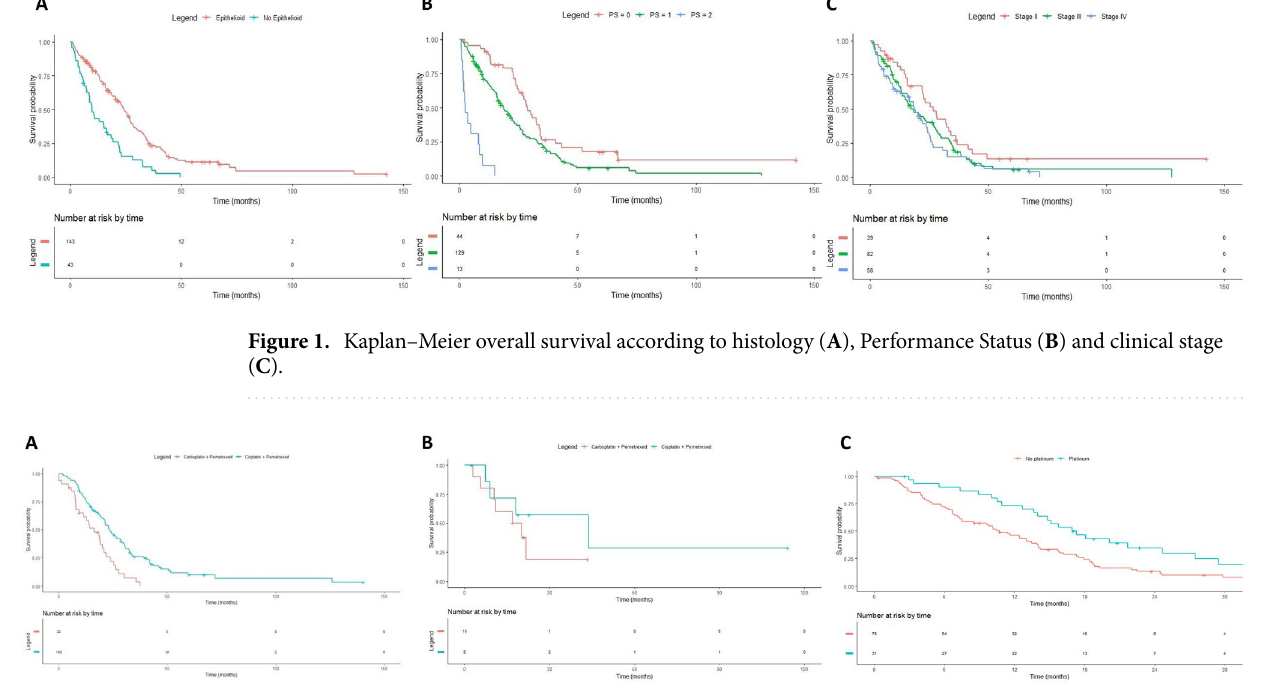
Figure 2. Kaplan–Meier overall survival according to type of systemic treatment: cisplatin versus carboplatin in first line ( A ), cisplatin versus carboplatin in second line ( B ) and platinum versus no platinum in second line ( C